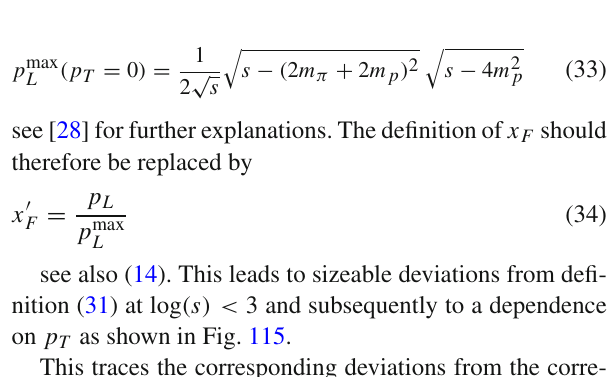
, p ) are shown in T F for 8 values of F